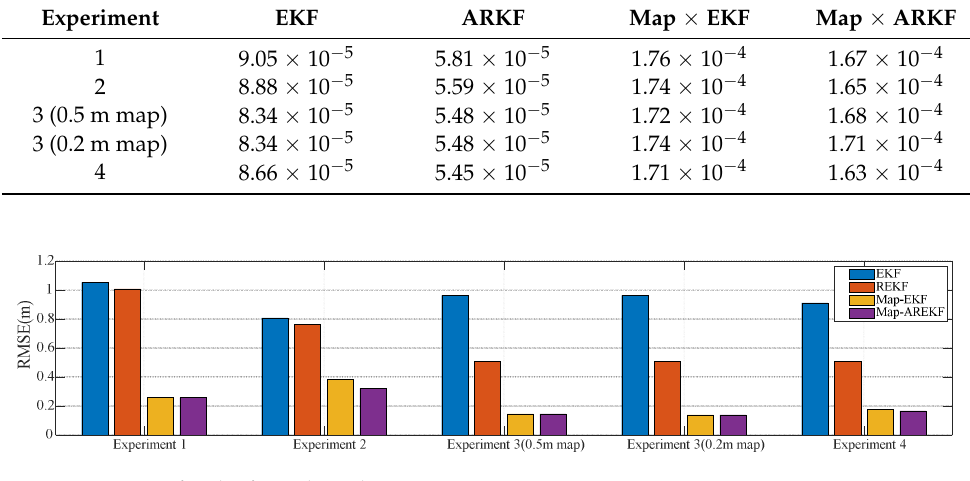
Figure 30. RMSE for the four algorithms.